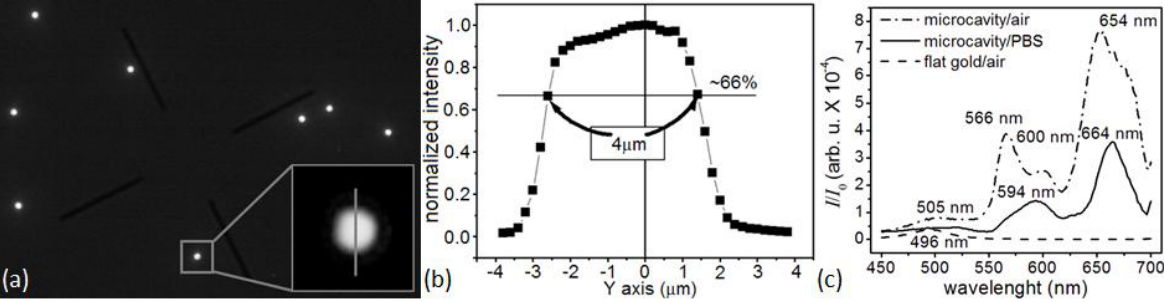
Figure 4. Microsensor characterization: ( a ) White-light transmission micrograph (40  , 0.85 NA) showing eight microsensors randomly distributed over a background of flat gold. The background is dark, showing the enormous level of microsensor light emission compared to the light transmission through the flat gold. (Insert) Microsensor detail: the grey line shows the trajectory of the profile in Figure 4(b). The flat gold film on the glass substrate has a spectral transmission of less than 10 −4 . ( b ) Intensity profile scan across a microsensor (convoluted by the seeing function of the optical apparatus). We aligned the microsensor so the highest intensity point of the microsensor’s emission lay at the origin of the focal axes, moved the nanostage laterally by 4 µm, keeping the focal position fixed, then scanned back along the line indicated in the insert in (a). ( c ) Spectra of the light emitted by a microsensor (a  780 polystyrene nanosphere covered with a ≈250 nm gold layer) used in Figure 5(d), in air (dot-dash line) and in PBS (solid line), and the spectrum of the light transmitted through the background flat gold film in air, ≈20 µm away from a microsensor (dash line). In all cases, we excited the microsensor using white light from the microscope illuminator (0.3